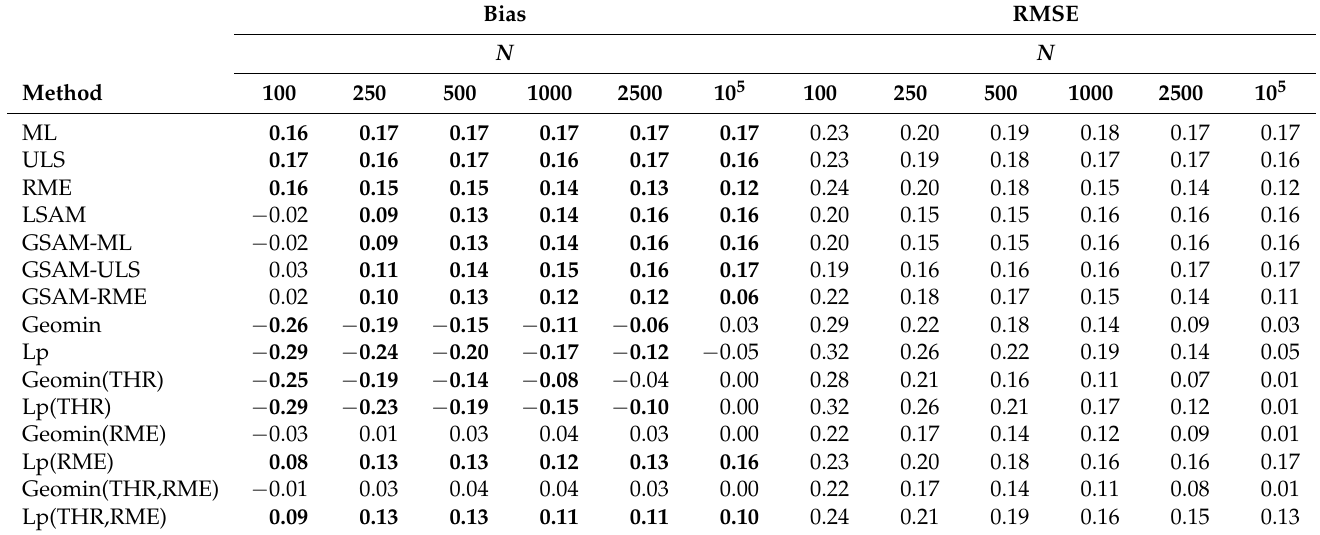
Table 7. Simulation Study 3 (two factors and one residual correlation and one cross loading): bias and root mean square error (RMSE) of estimated factor correlation as a function of sample size with one positive residual correlation and one positive cross loading in the data-generating